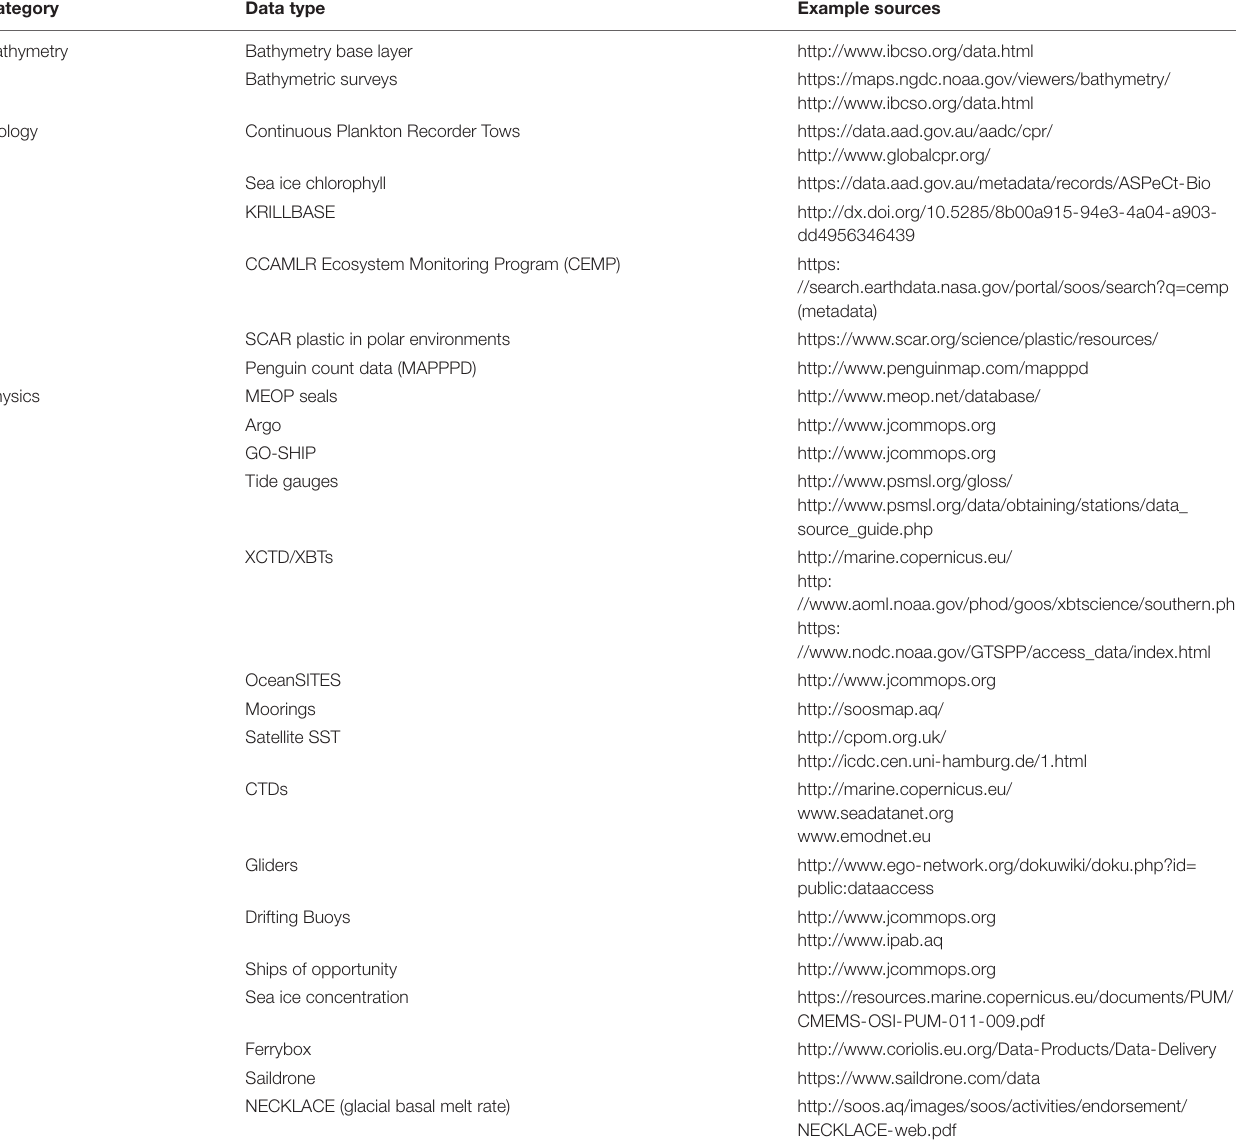
TABLE 1 | Aggregated and standardised data products currently available through SOOSmap to support ecosystem assessments in the Southern Ocean.